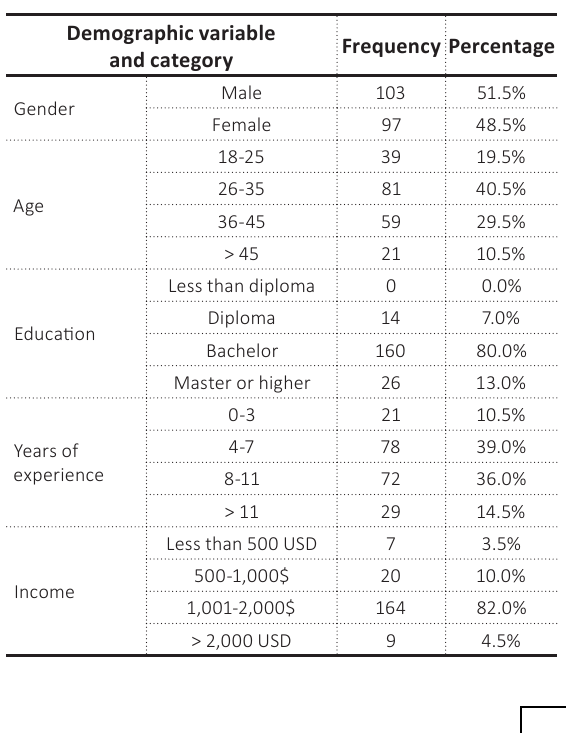
Source: Researchers.